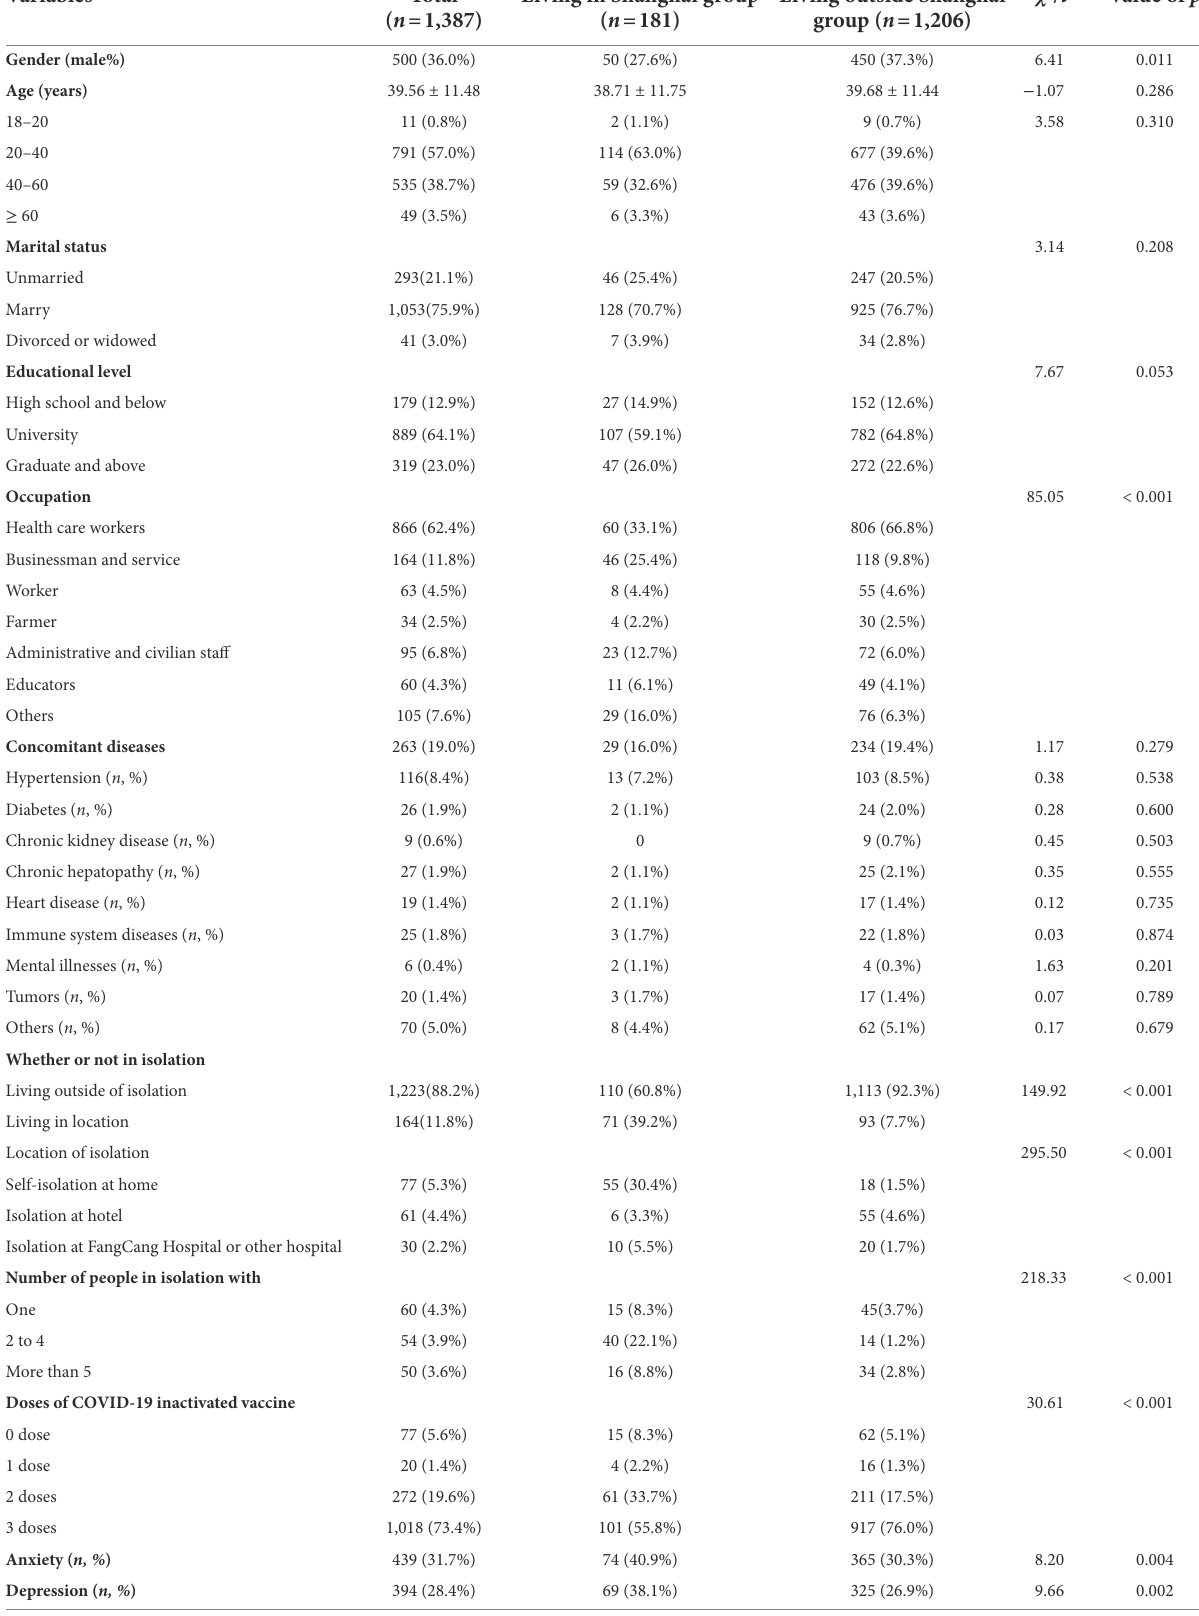
TABLE 1 Baseline characteristics of the enrolled participants living in Shanghai and outside Shanghai. Variables Total